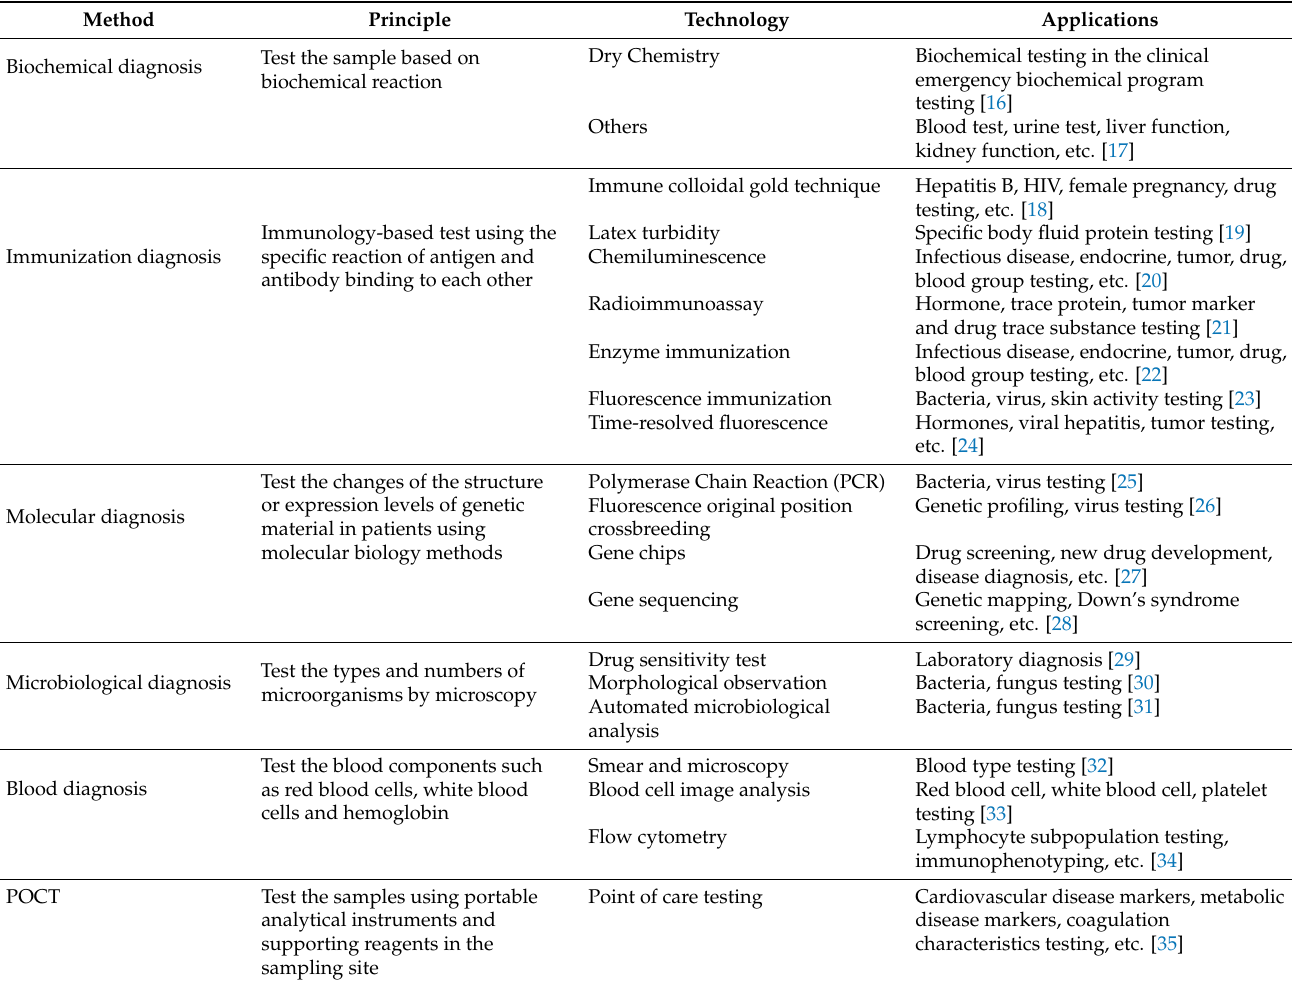
Table 1. Classification of the main methodology of in vitro diagnostics.